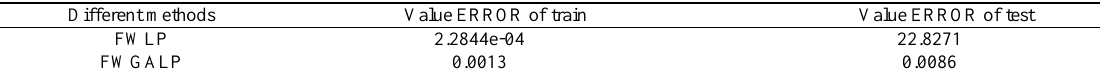
Table 8. Error results obtained using different methods for Example